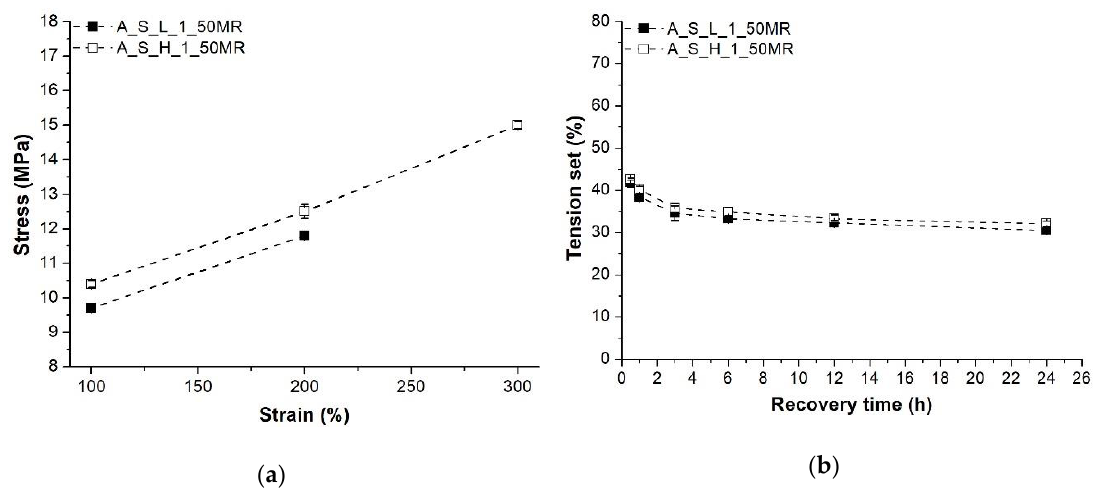
Figure 6. Stress at 100%, 200% and 300% elongation and the tension set of the TDVs produced with different compounding temperature profiles: ( a ) Stress; ( b ) Tension set.